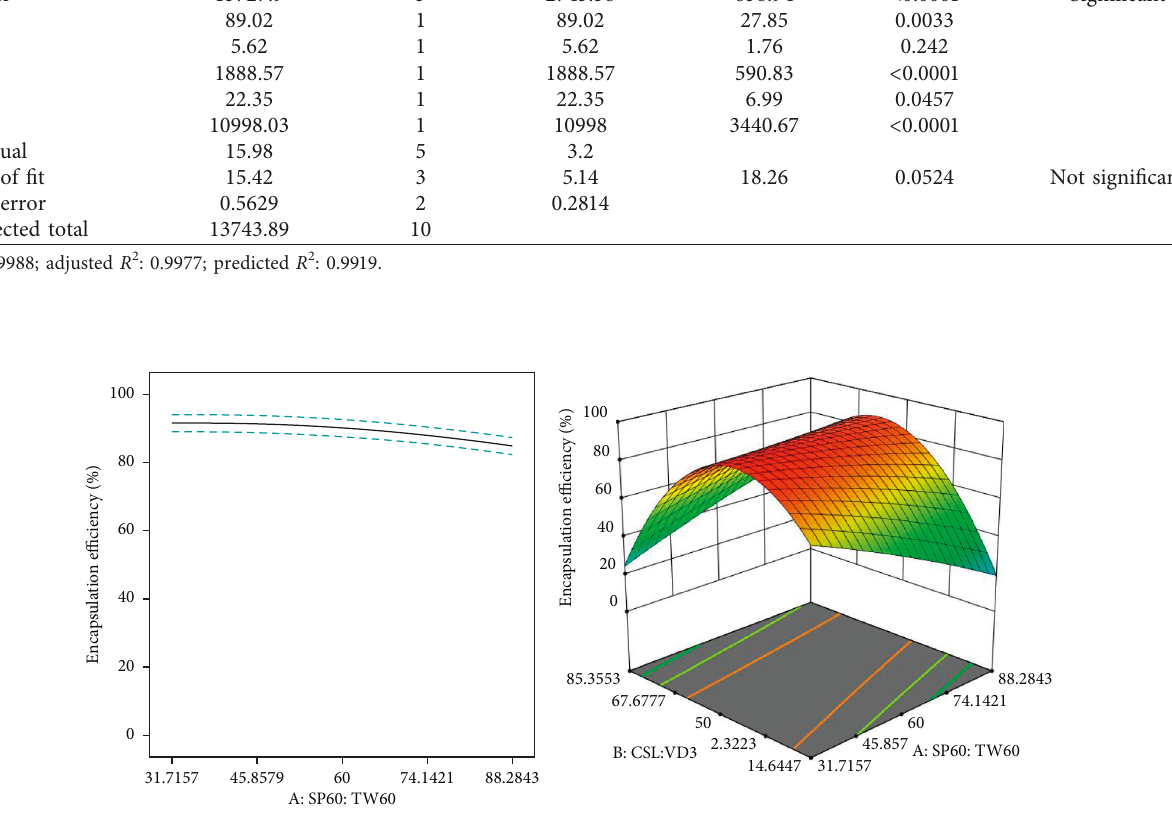
Figure 3: Effects of Span 60: Tween 60 and cholesterol: vitamin D3 ratio on encapsulation efficiency of niosome.